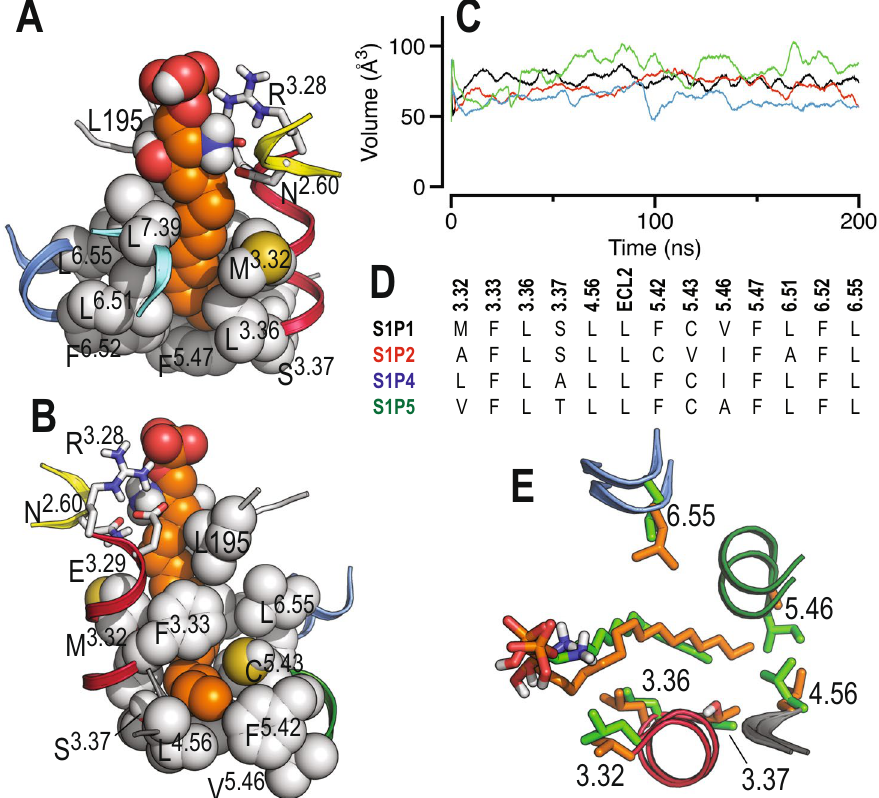
Figure 5. Molecular dynamics simulations of sphingosine-1-phosphate receptors. ( A ) Detailed view of the narrow channel of S1P 1 where the alkyl tail of S1P (in orange) must expand. The end of the channel is delimited by the amino acids at positions 4.56, 5.42 and 5.46. The structure depicts the final conformation at 0.2 μ s. ( B ) Same as in panel A but rotated 180°. ( C ) Volume of the channel in S1P 1 (black), S1P 2 (red), S1P 4 (blue) and S1P 5 (green) along the MD trajectories with the natural S1P agonist as calculated with POVME 49 . ( D ) Sequence alignment, among sphingosine receptors, of the amino acids forming this channel. ( E ) The final conformation, at 0.2 μ s, obtained in the MD simulations of S1P 4 in complex with C16 (in green) and S1P 5 in complex with C20 (in